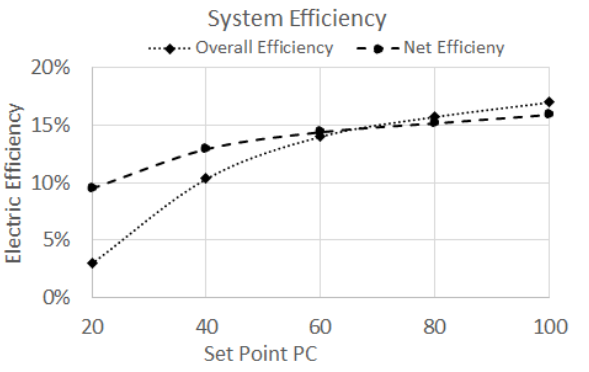
Figure 2. Global and net efficiency of the MTT Enertwin as measured by [17]. Adapted from [17]. Copyright 2017, Instituto Superior Técnico Lisbon.